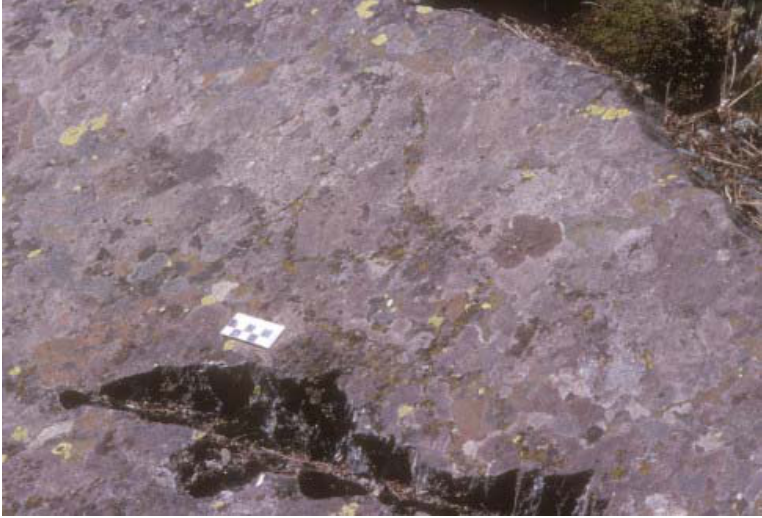
Figure 20. Horse, worn and covered with lichen. Pre-Bronze Age. Aral Tolgoi. (http://oregondigital.org/u?/maic,2095).